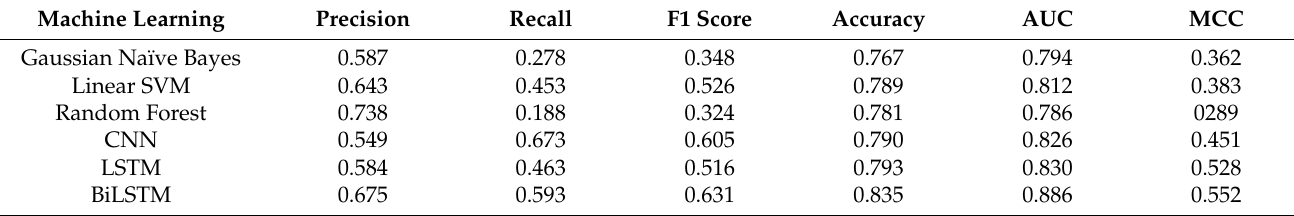
Table 3. Comparison of performance evaluation.